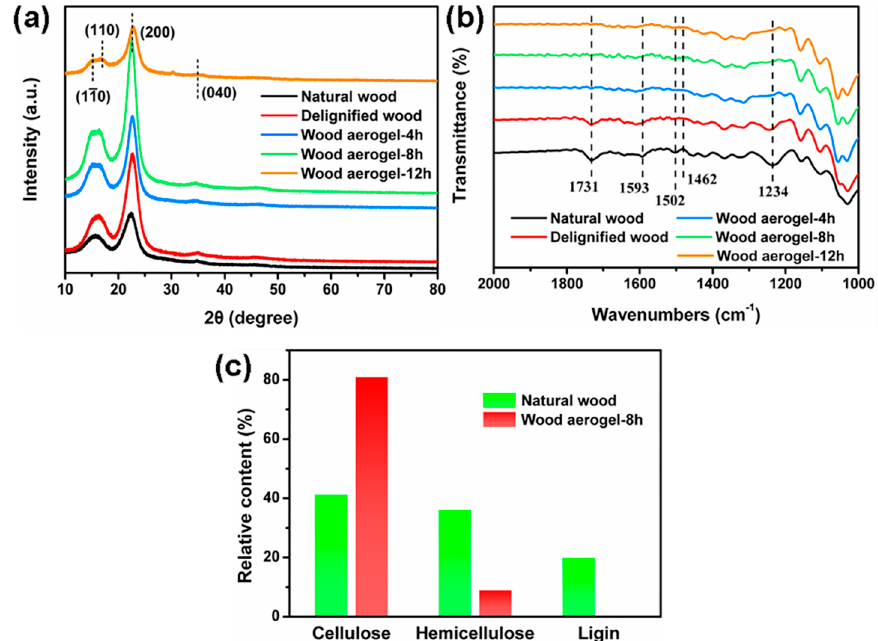
Figure 3. Chemical characterization of different wood specimens. ( a ) X-ray diffraction (XRD) patterns of different wood specimens. ( b ) Fourier transform infrared spectroscopy (FTIR) spectra of different wood specimens. ( c ) Relative content of cellulose, hemicellulose, and lignin of wood aerogel.